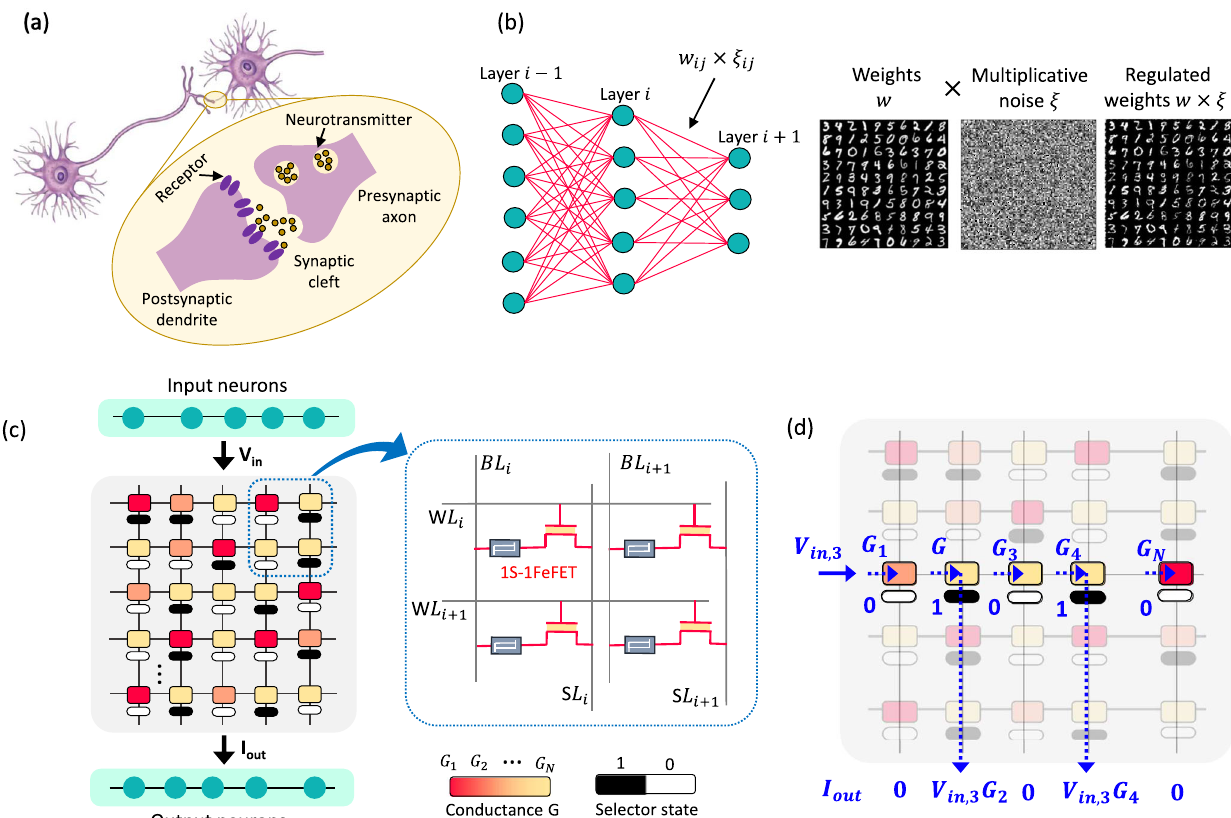
Fig. 1 Overview of stochastic synapse. a Synaptic stochasticity occurring at the molecular level in biological neural networks. The presynaptic neuronal spike causes the release of neurotransmitters at the synaptic release site with a probability around 0.1. b Schematic of a Neural Sampling Machine (NSM) incorporating a Bernoulli or “ blank-out ” multiplicative noise in the synapse. This acts as a continuous DropConnect mask on the synaptic weights such that a subset of the weights is continuously forced to be zero. c Illustration of an NSM implemented in a hardware using crossbar array architecture implementing compute-in- memory. The analog weight cell implemented using eNVMs are placed at each cross-point and are augmented with a stochastic selector element. This allows selectively sampling or reading the synaptic weights G ij with some degree of uncertainty, based on random binary variables ξ ij generated for each of the synapse. d Illustration of a scenario where an input voltage V in, 3 is applied to a row of the synaptic array with conductance states G ¼ f G 1 ; G 2 ; G 3 ; G 4 ; ¼ ; G N g . Depending on the state of the selectors in the cross-points, an output weighted sum current I out ¼ f 0 ; G same as multiplying the weight sum of w ij z j with a multiplicative noise ξ ij . WL word line, BL bit line, SL source line, V in input voltage, I out output current, G